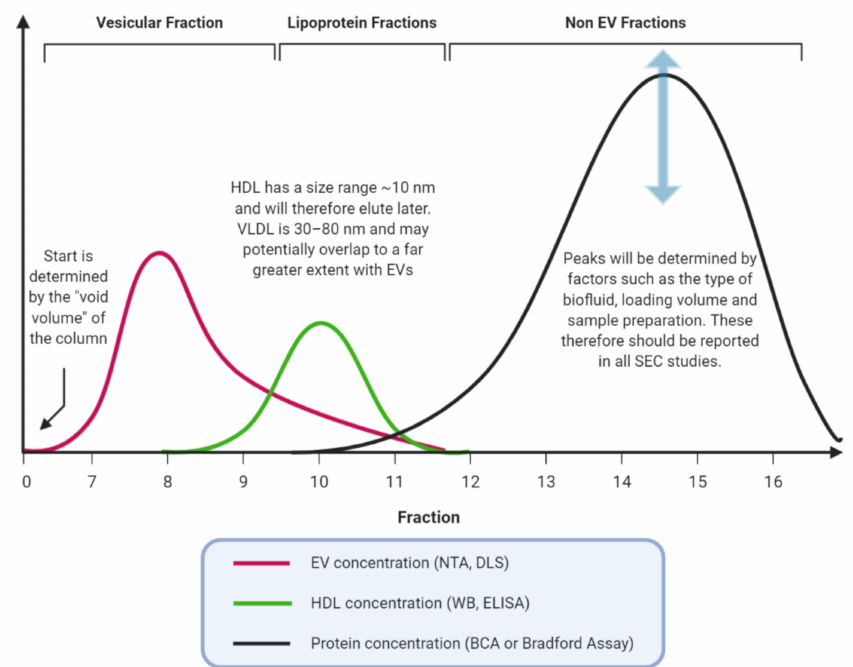
Figure 2. Schematic graph showing make up of consecutive fractions. EVs elute first but there is often an overlap between similarly sized particles e.g., small EVs and lipoproteins. Assessing these potential contaminants should be a mandatory feature of size-exclusion chromatography (SEC) EV studies. NTA,